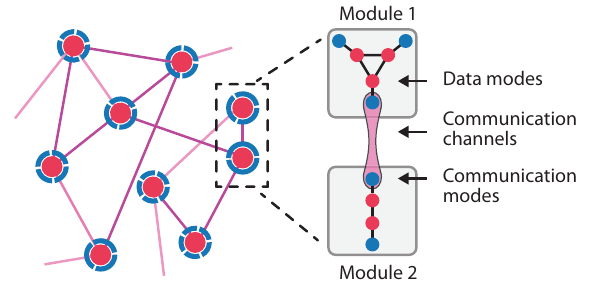
FIG. 18. A conceptual illustration of a modular quantum computer . Each module consists of a small number of error- corrected logical elements (pink) equipped with robust quan- tum operations between them. In addition, each module is also designed to have its communication elements (blue) where quan- tum information can be coherently transferred on the fly across different